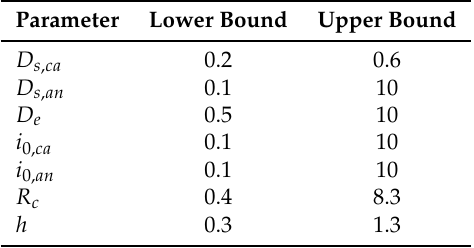
Table 5. Effective ranges of the multipliers and dimensionless decision variables for cell cycling calibrations. Parameter Lower Bound